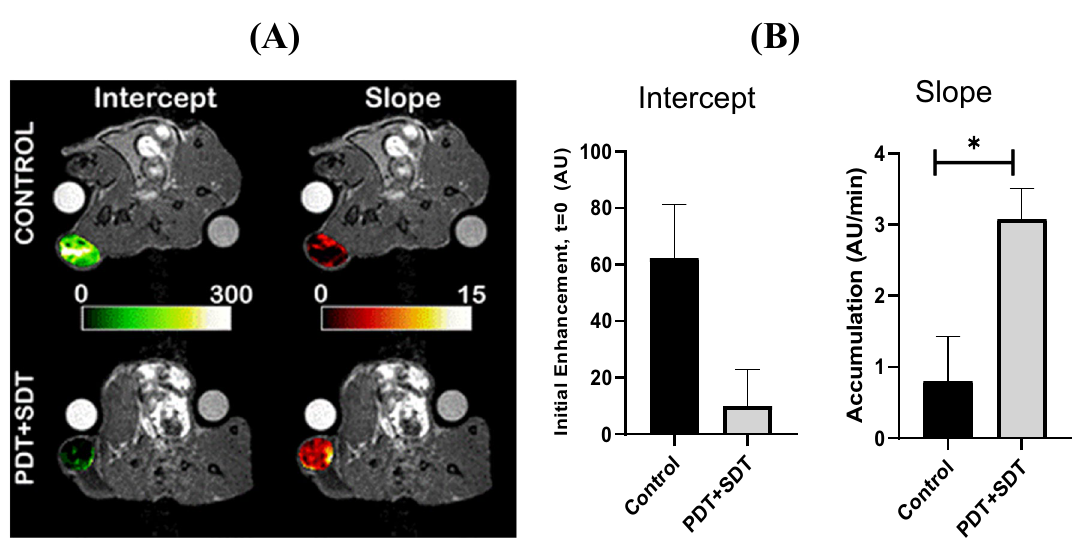
Figure 9. Assessment of tumor vascular changes by MR imaging. ( A ) Pseudo-colorized dynamic enhancement maps of a control mouse (top) and treated mouse (bottom) calculated on a voxel-by-voxel basis. A clear reduction in the blood flow in the tumor (intercept) and increased permeability (slope) in the treated mouse. ( B ) Grouped analysis between control and treated animals (n = 3 each). A substantial reduction in initial enhancement (intercept) was observed following PDT + SDT treatment, as well as increased permeability (slope) (*p = 0.039, two-tailed Student’s